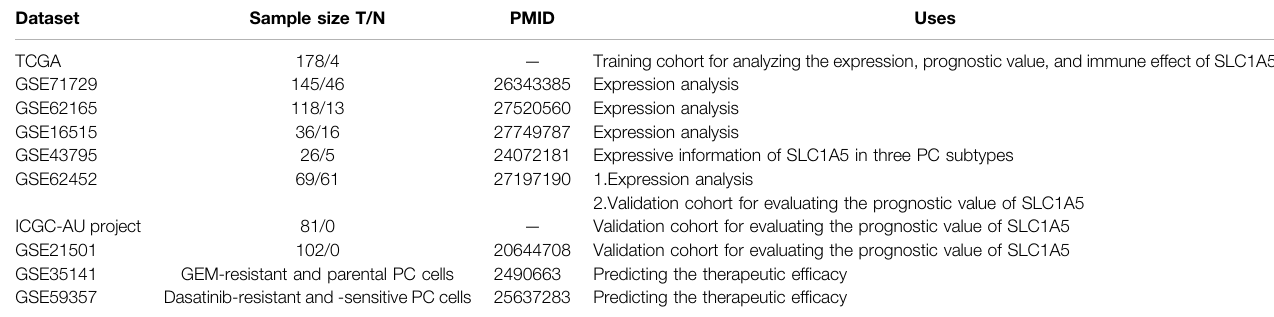
TABLE 1 | The uses of datasets in the present